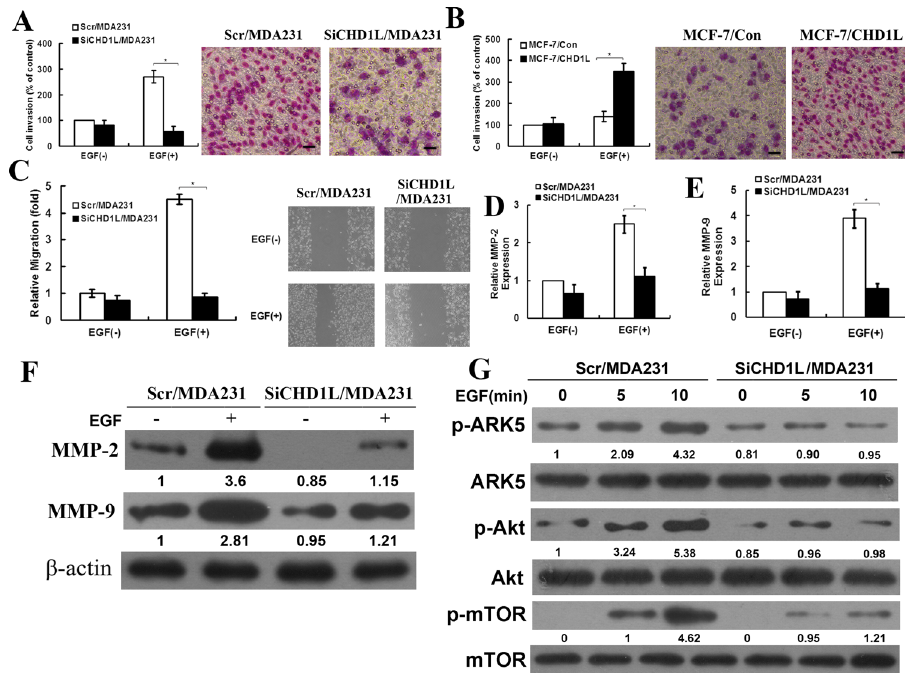
Fig 3. CHD1L promotes invasion of breast cancer cells. (A) Invasion of breast cancer cell line MDA-MB- 231 with EGF stimulation was analyzed. Left, Quantification of penetrated cells was analyzed. Bars, standard deviation. * , P < 0.05 (Student ’ s t test, versus Scr/MDA231 with EGF stimulation). Right, Images were taken at a magnification. Scale bar: 20 μ m. (B) Invasion of breast cancer cell line MCF-7 with EGF stimulation was analyzed. Left, Quantification of penetrated cells was analyzed. Bars, standard deviation, * , P < 0.05 (Student ’ s t test, versus MCF-7/Con with EGF stimulation). Right, Images were taken at a magnification. Scale bar: 20 μ m. (C) Cell migration was assessed using the wound healing assay. Left, Cell motility rates of SiCHD1L/MDA231 and Scr/MDA231. Bars, standard deviation. * , P < 0.05 (Student ’ s t test, versus Scr/ MDA231 with EGF stimulation). EGF, 10 ng/mL. Right, Images were taken at 0 and 24 h. (D) MMP-2 level in culture media of SiCHD1L/MDA231 and Scr/MDA231 cells was detected using ELISA. EGF, 10 ng/mL. Bar, standard deviation. * , P < 0.05 (Student ’ s t test, versus Scr/MDA231 with EGF stimulation). (E) MMP-9 level in culture media of SiCHD1L/MDA231 and Scr/MDA231 cells was assessed using ELISA assay, EGF, 10 ng/ mL. Bars, standard deviation. * , P < 0.05 (Student ’ s t test, versus Scr/MDA231 with EGF stimulation). (F) MMP-2 and MMP-9 proteins were extracted in Scr/MDA231 and SiCHD1L/MDA231 cells with or without EGF stimulation, and Western blot was performed using an antibody to MMP-2 and MMP-9. β -Actin was used as a loading control. (G) Protein levels of pAkt, Akt, pARK5, ARK5, pmTOR, and mTOR were detected using Western blot. Each result is representative of at least three independent experiments. Akt was used as a loading control. Quantification of relative protein levels on three different Western blot analyses is shown below the